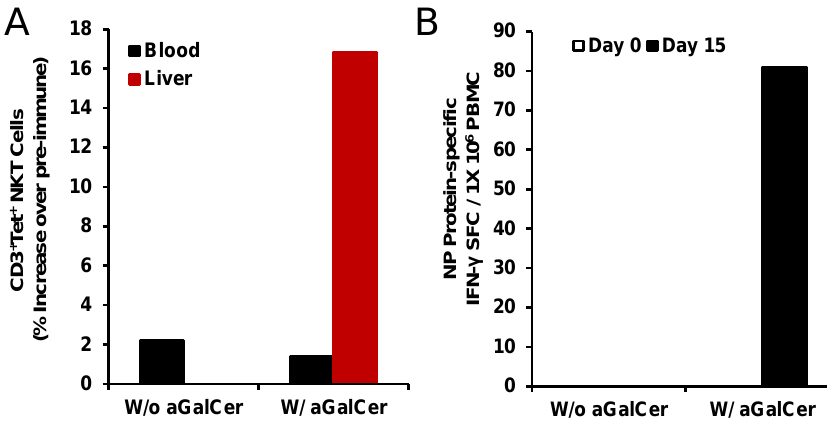
Figure 4. Activation of NKT cell and adaptive immune responses after intranasal delivery of α-GalCer to rhesus macaques: Intranasal immunization with the recombinant nucleoprotein of influenza (NP protein 20 µg) along with, but not without, α-GalCer (125 µg) induced expansion of NKT cells in the blood and liver tissues as determined by flow cytometry staining with APC CD1d tetramer (panel A ). Data are calculated as percent increase of CD3 + , CD1d tetramer + NKT cells relative to pre-immune values for one monkey each immunized with the NP protein in the absence or presence of α-GalCer. Adaptive immune responses to the NP protein were determined in terms of IFN-γ producing cells in the PBMC by the cytokine ELISpot assay (panel B ). Data are shown as IFN-γ spot forming cells (SFC) per 1 × 10 5 input cells and antigen specific responses were adjusted to background medium